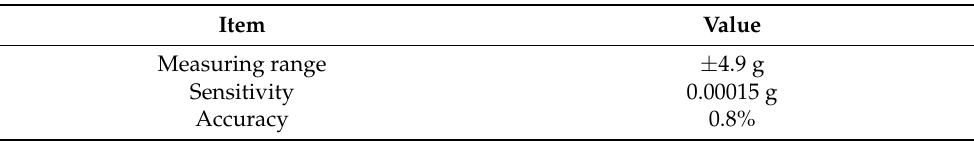
Table 2. Specifications of the inertial measurement unit (IMU).